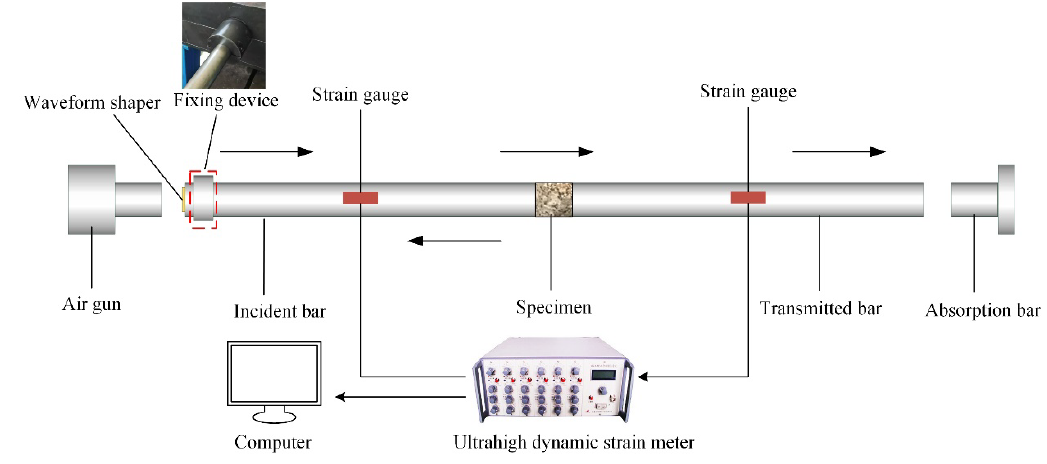
Figure 2. Schematic diagram of the SHPB experimental device.